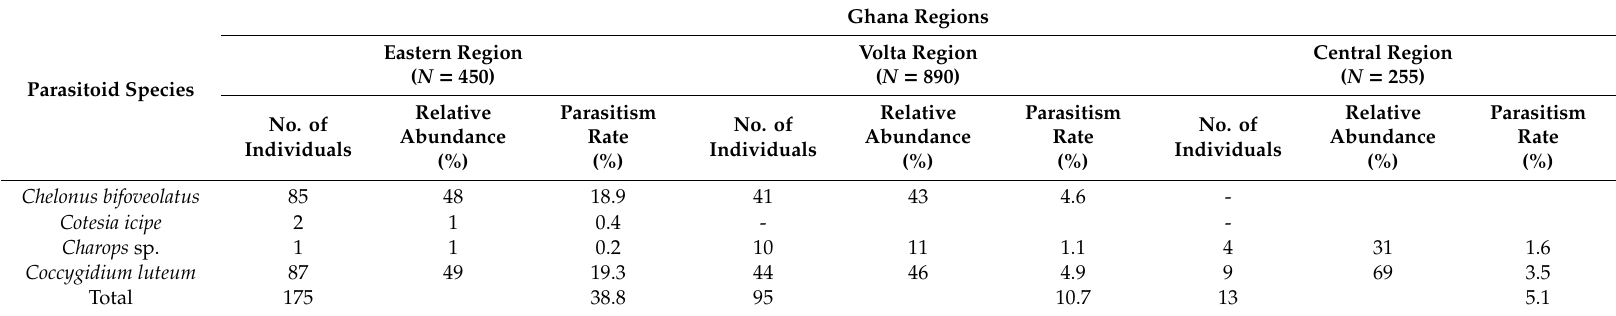
Table 4. Abundance and parasitism rates by egg–larval and larval parasitoids of Spodoptera frugiperda in the Eastern, Volta and Central regions of Ghana. Mortality rates of the collected S. frugiperda larvae that died but produced no parasitoids are 9.3%, 7.0% and 1.6% in the Eastern, Volta and Central regions, respectively.